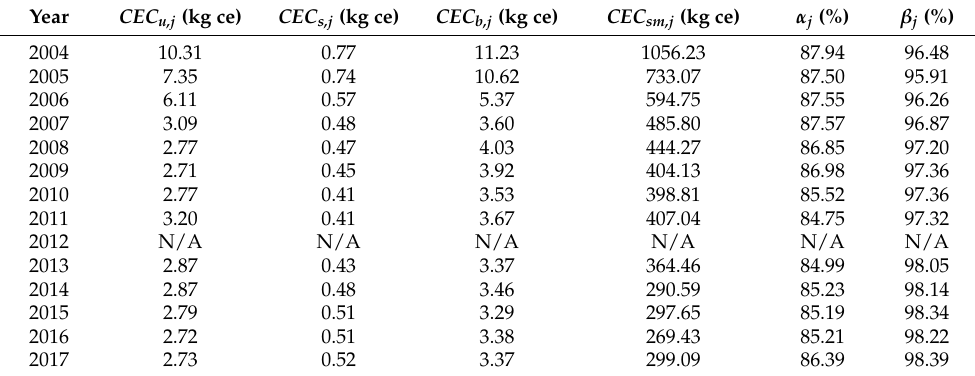
Table 1. Energy consumption and recovery rate of copper production from 2004 to 2017 [34].